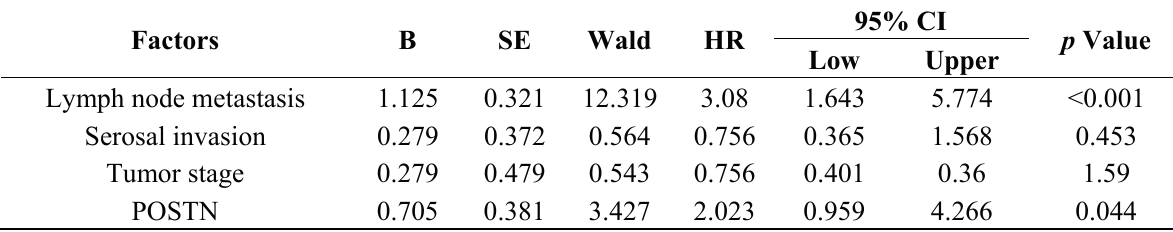
Table 3. Multivariant survival analyses of various factors in patients with colorectal cancer. Factors B SE